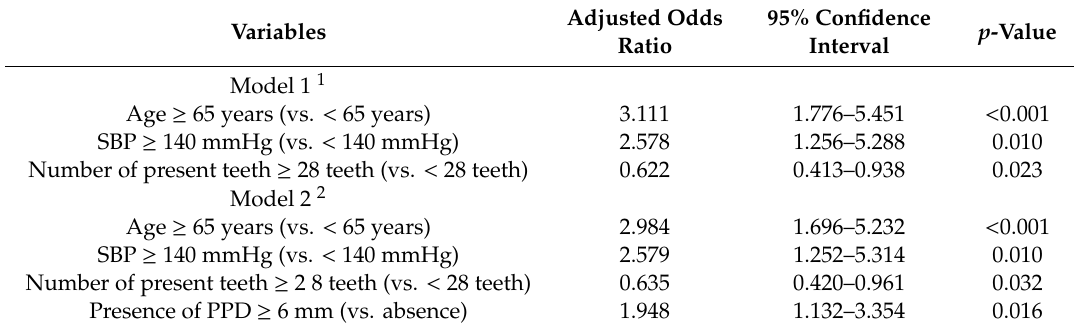
Table 5. Factors associated with DSWMH lesions: multiple logistic regression